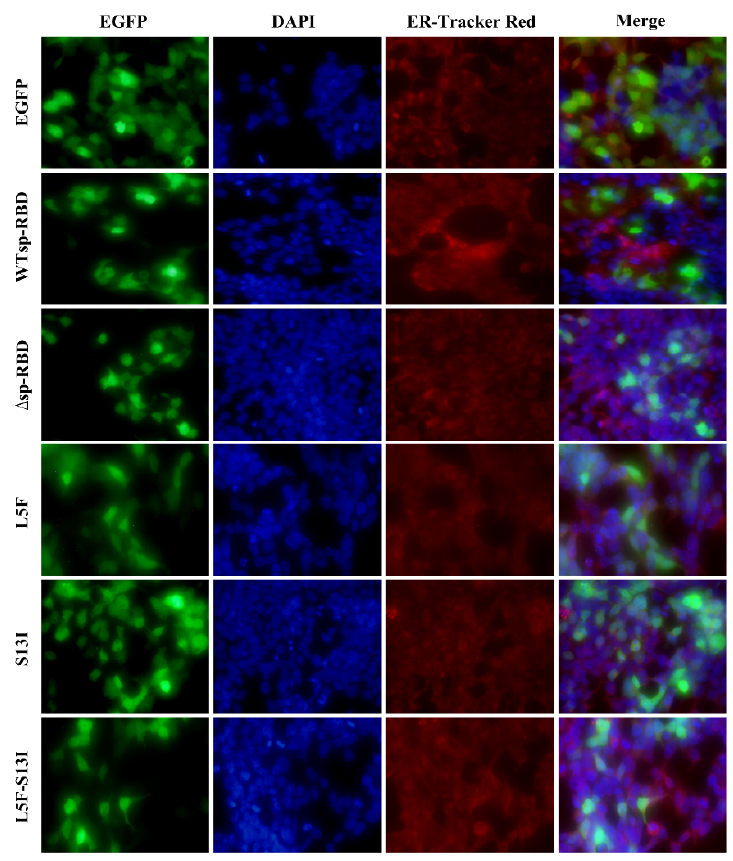
Figure 2. Signal peptides mediate the localization of SARS ‐ CoV ‐ 2 RBD protein. WT means wild ‐ type signal peptide of S protein; The mutants L5F and S13I were present in Iota (B.1.526) and Epsilon (B.1.429) variants; L5F ‐ S13I was a newly constructed double mutant. The fluorescence for EGFP (green), DAPI (blue), ER ‐ Tracker ‐ Red (red) and the merge of the three channels are displayed.